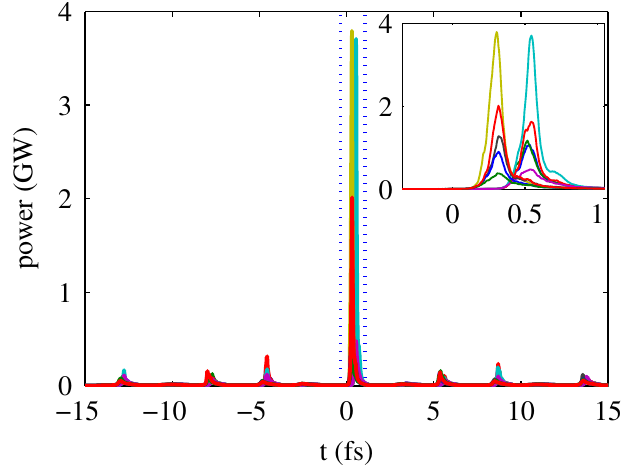
FIG. 10. (Color) Radiation profiles with a phase shift of 0.1 fs and (cid:2) 0 : 1 fs between the two lasers, five runs for each phase shift using different shot noise realizations. The inset zooms in the central spikes in the dotted blue